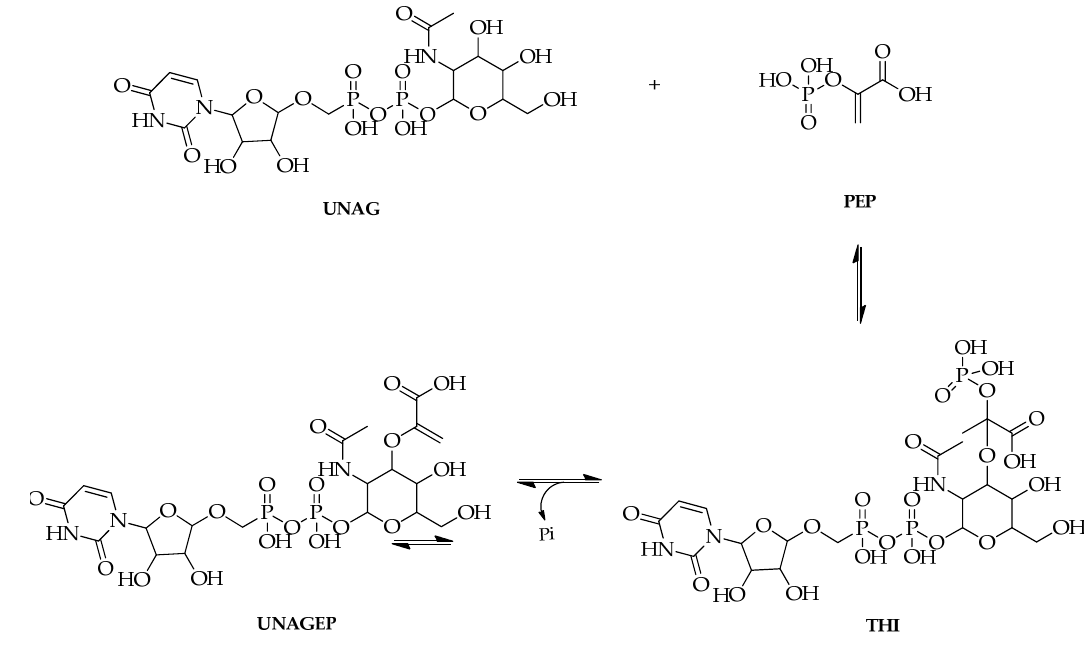
Figure 4. Catalytic reaction on the MurA enzyme [106]